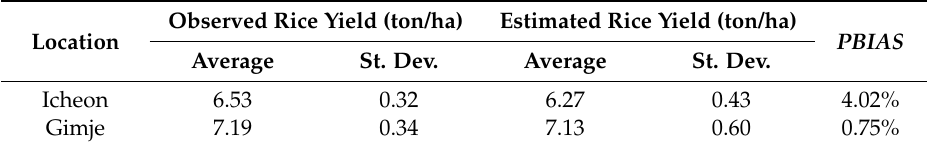
Table 6. Estimated yield of rice at the study sites